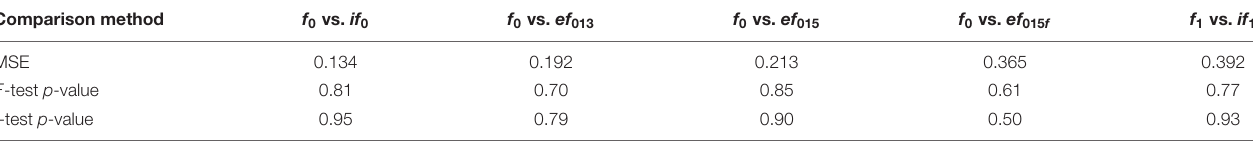
TABLE 9 | MSE, F -test, and t -test results for FFE imputations and estimations vs. LAHM data on 175 observations. Comparison method